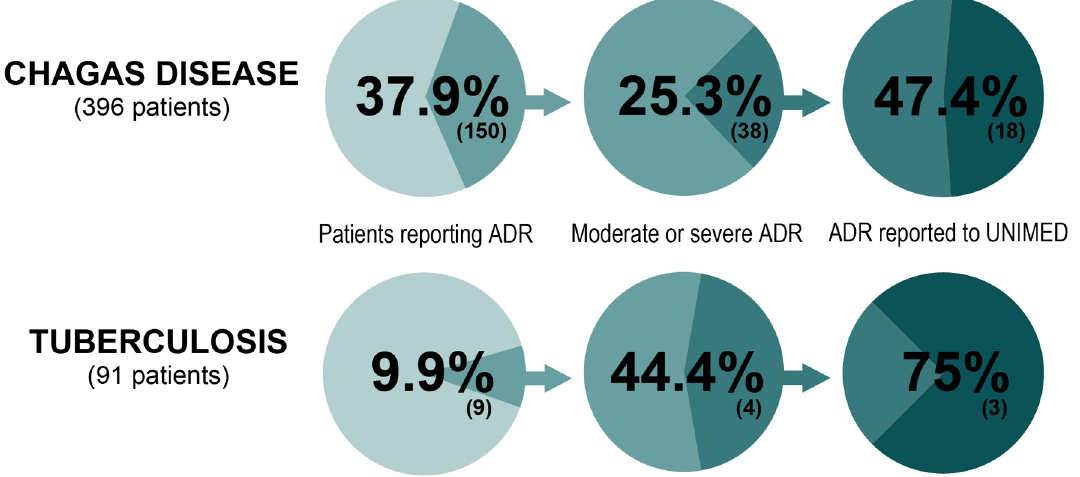
Fig 3. Summary of the intervention results for CD (A) and TB (B). Total patients starting treatment for CD (A) or TB (B), reporting ADRs related to CD (A) or (TB) treatment according to the medical records, total ADRs classified as moderate or severe in the medical records, and total ADRs finally reported to the Bolivian pharmacovigilance system. Less than half of all moderate and severe ADRs presented during CD treatment and collected in the medical records were reported to the Bolivian pharmacovigilance system. The figures are slightly better for TB, with 75% of the ADRs reported to UNIMED. ADR: adverse drug reaction; UNIMED: Pharmacovigilance Unit of the Bolivian Ministry of Health; CD: Chagas Disease; TB: Tuberculosis.